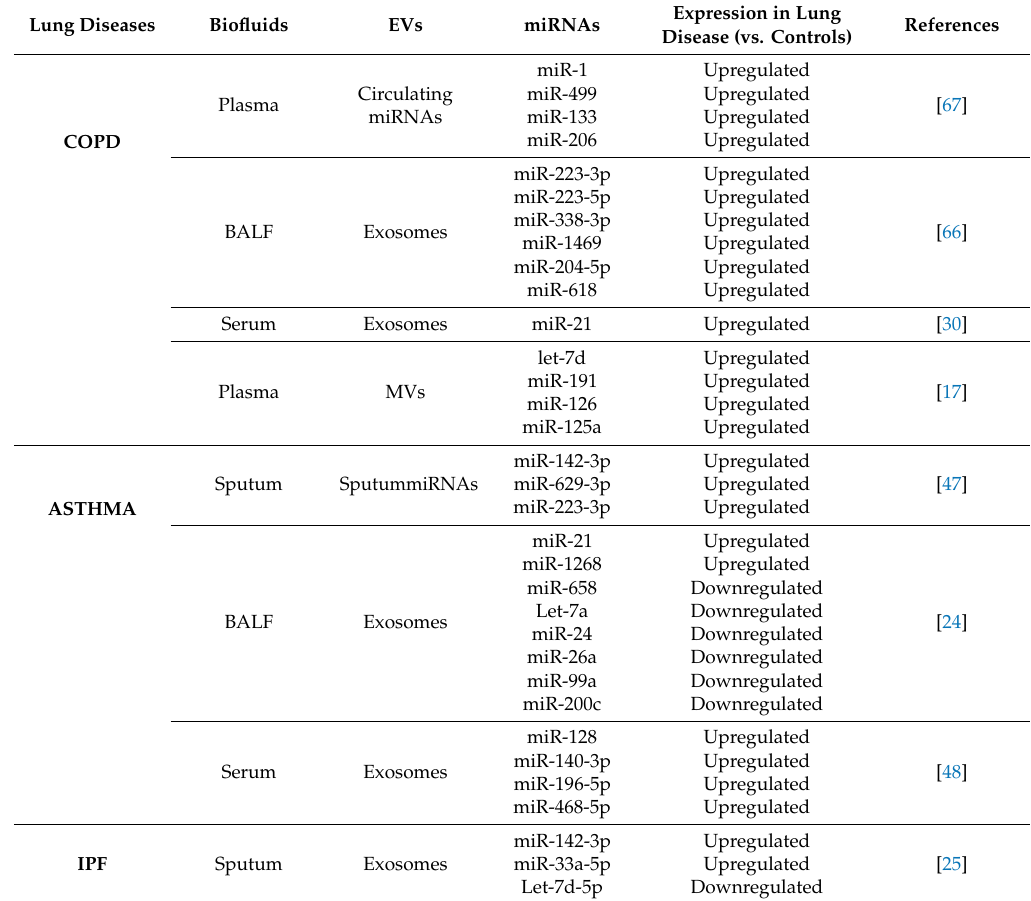
Table 2. EV miRNAs associated with lung